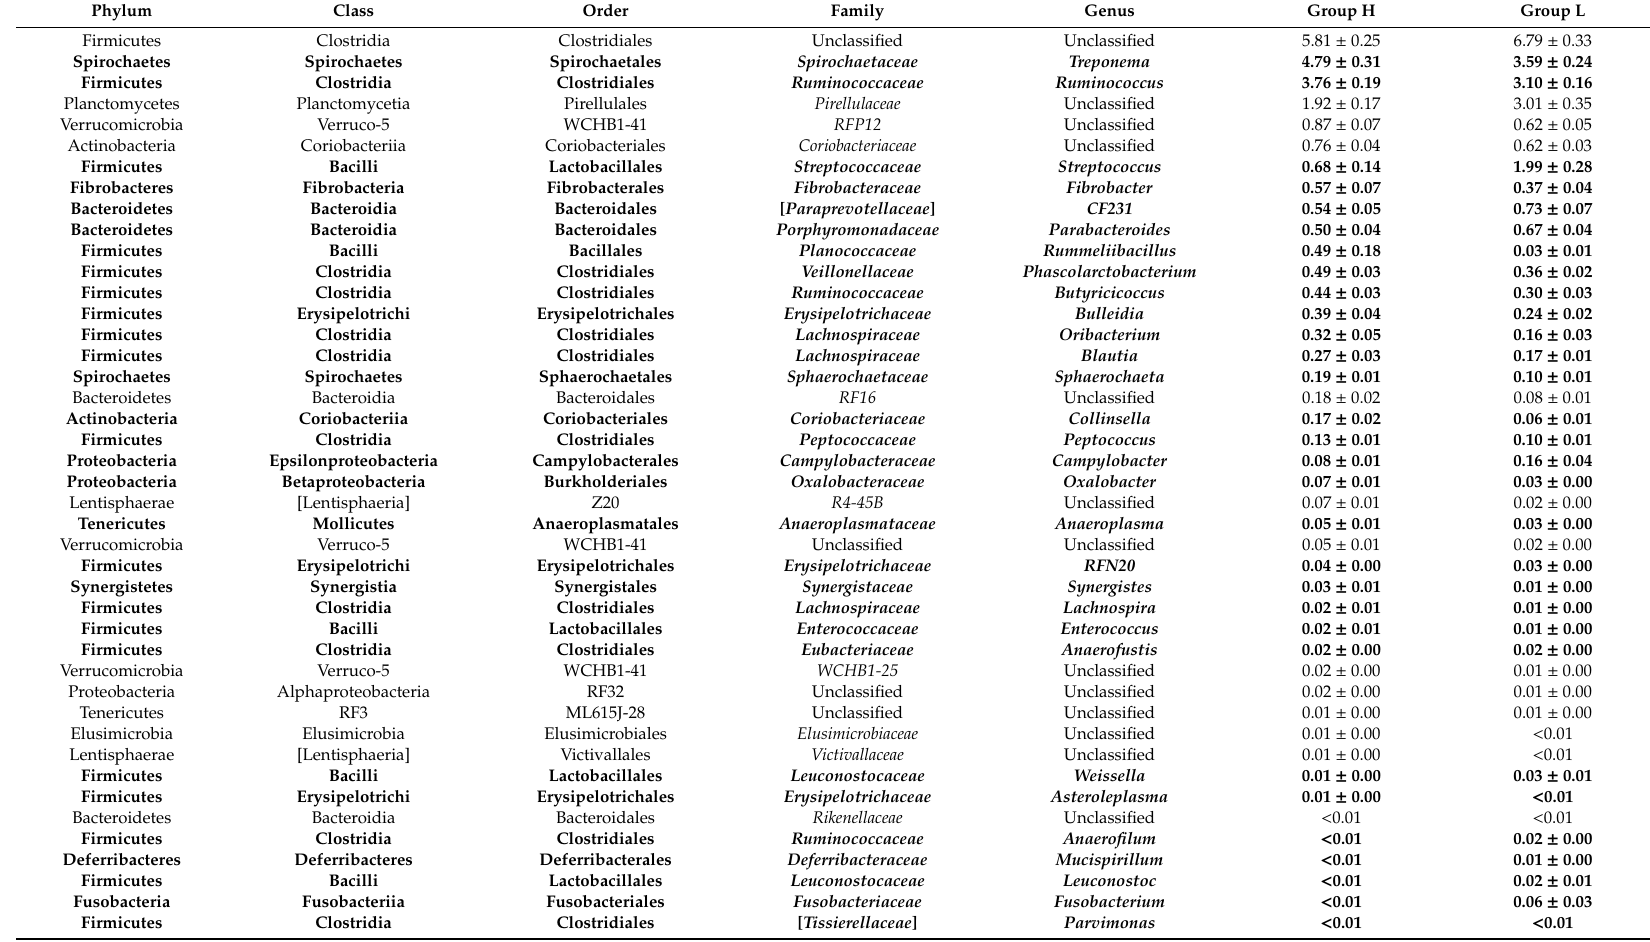
Table 3. Relative abundances of 43 bacterial genera that significantly di ff ered between high- and low-reproductive performance groups.